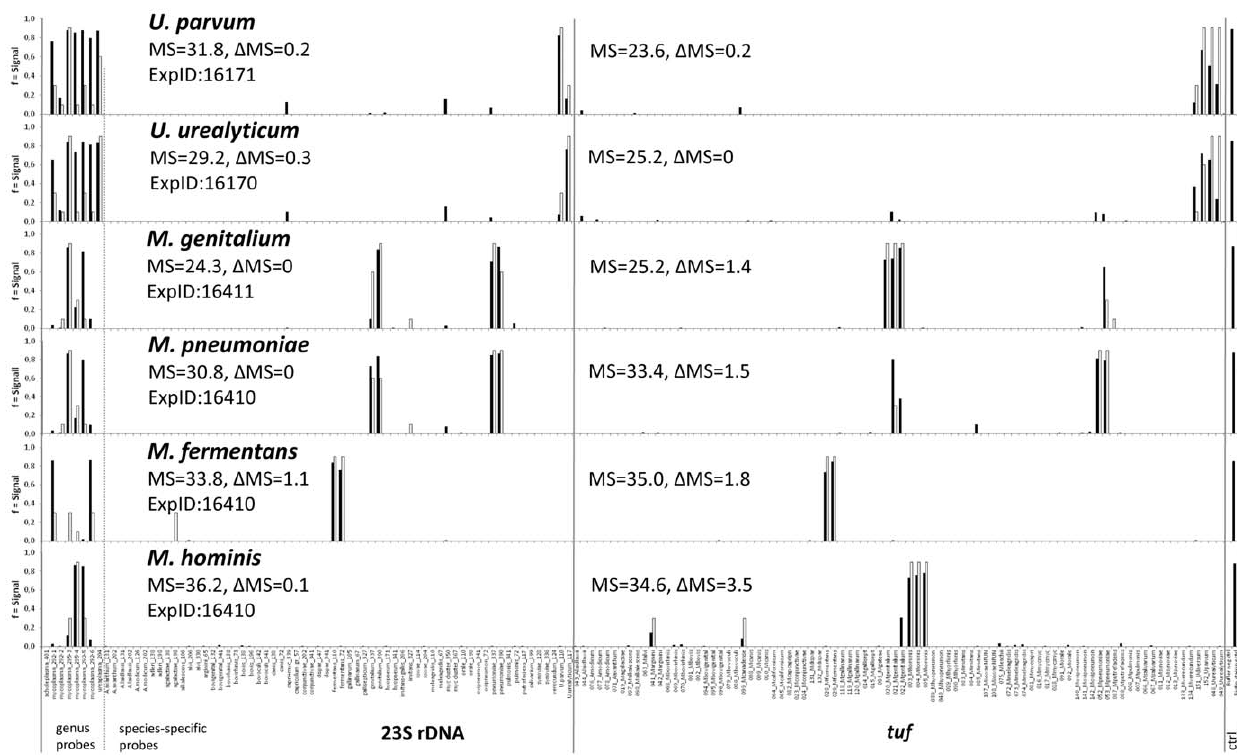
Figure 3. Differentiation among human Mycoplasma and Ureaplasma spp. based on the combination of probes from 23S rDNA and the tuf gene. Matching scores (MS) and Delta MS values are given for both gene loci in each hybridization experiment. Black bars denote experimental signals, gray bars denote theoretically predicted signals. Control bars at the right-hand margin show spotting buffer (background control) and biotinylated oligonucleotide (staining control).